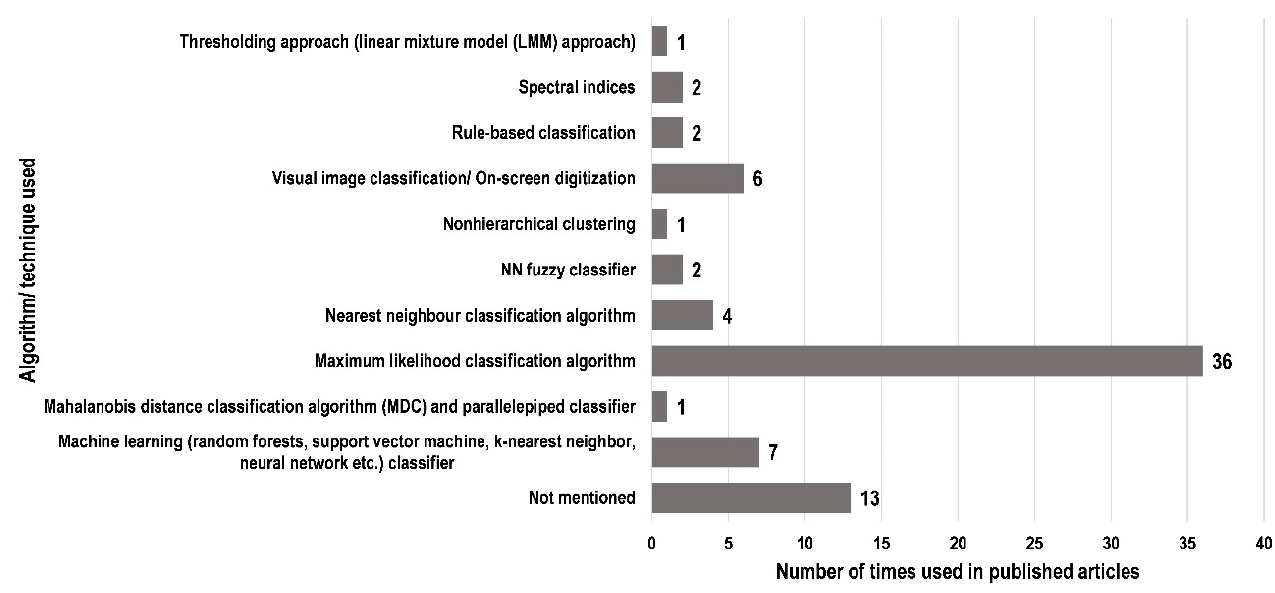
Figure 8. Various image classification algorithms used by the researchers (1993–2021).